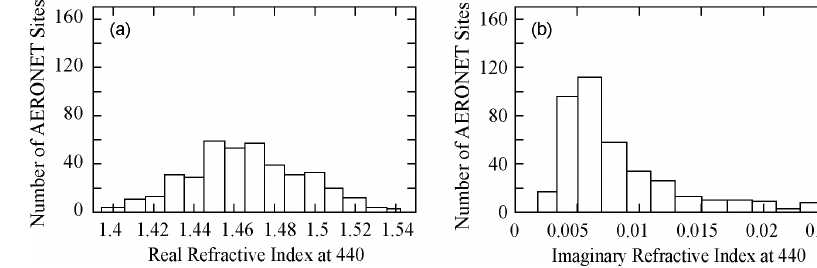
Figure 7. Real (a) and imaginary (b) refractive frequency.